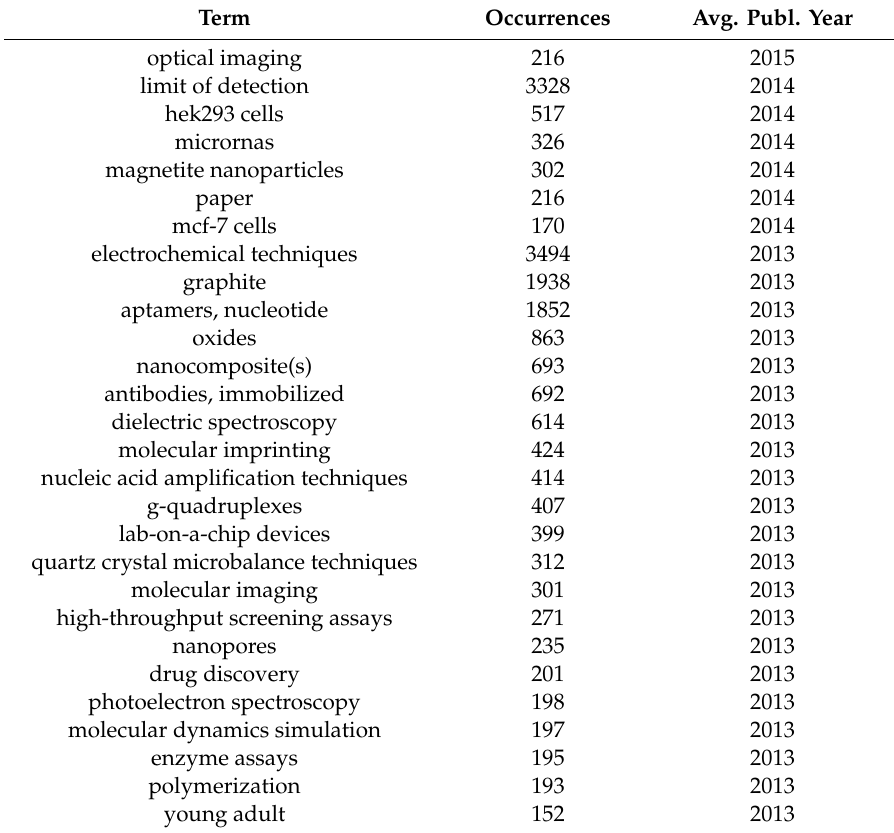
Table 7. Newer MeSH Terms among those depicted in Figure 21.